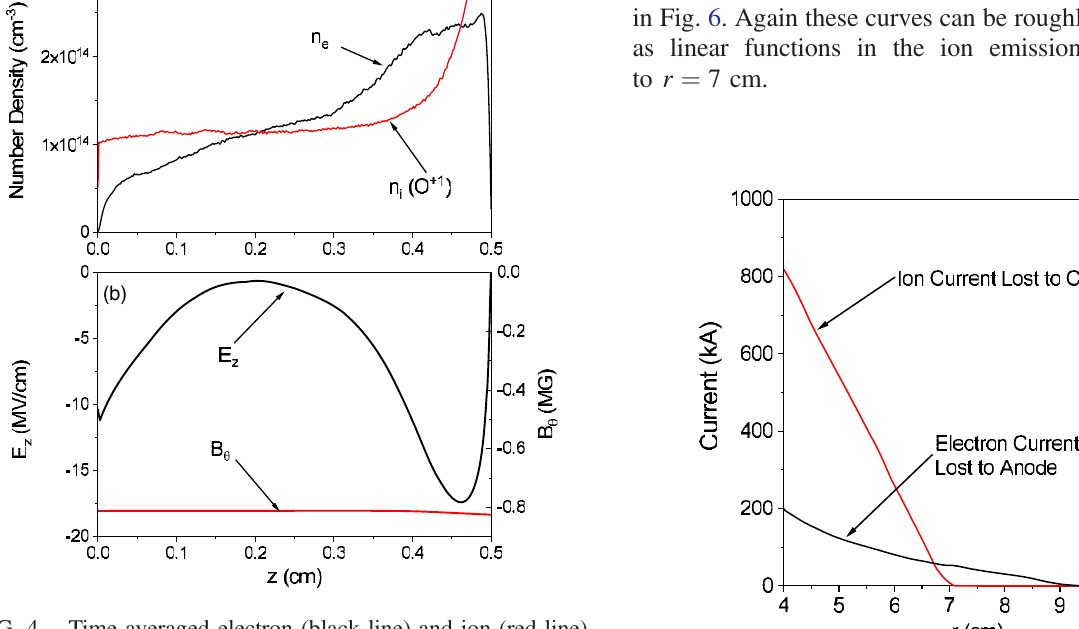
FIG. 4. Time averaged electron (black line) and ion (red line) number densities at r ¼ 5 cm (spatially averaged between 4.9 and 5.1 cm). Time averaged E (black line) and B θ (red line) FIG. 6. Average electron current lost to the anode (black) and z fields at r ¼ 5 cm (spatially averaged between 4.9 and 5.1 cm). ion current lost to the cathode (red) as a function of radius from The cathode is at z ¼ 0 and the anode is at z ¼ 0 . 5 cm. the baseline